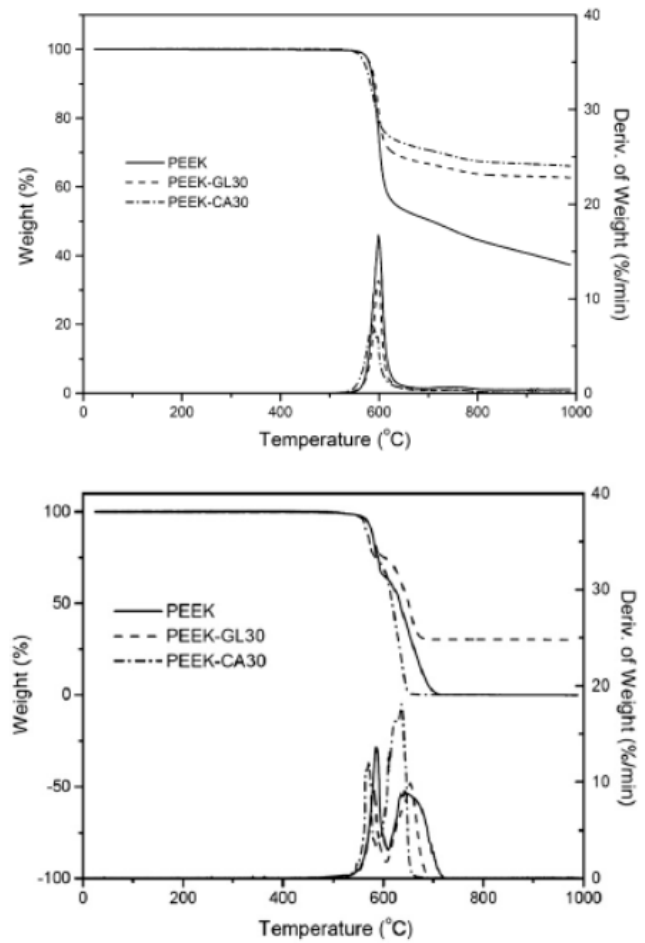
Figure 17. Thermal decomposition of PEEK and its glass (GL30) and carbon (CA30) fibre composites under nitrogen ( top ) and in air ( bottom )